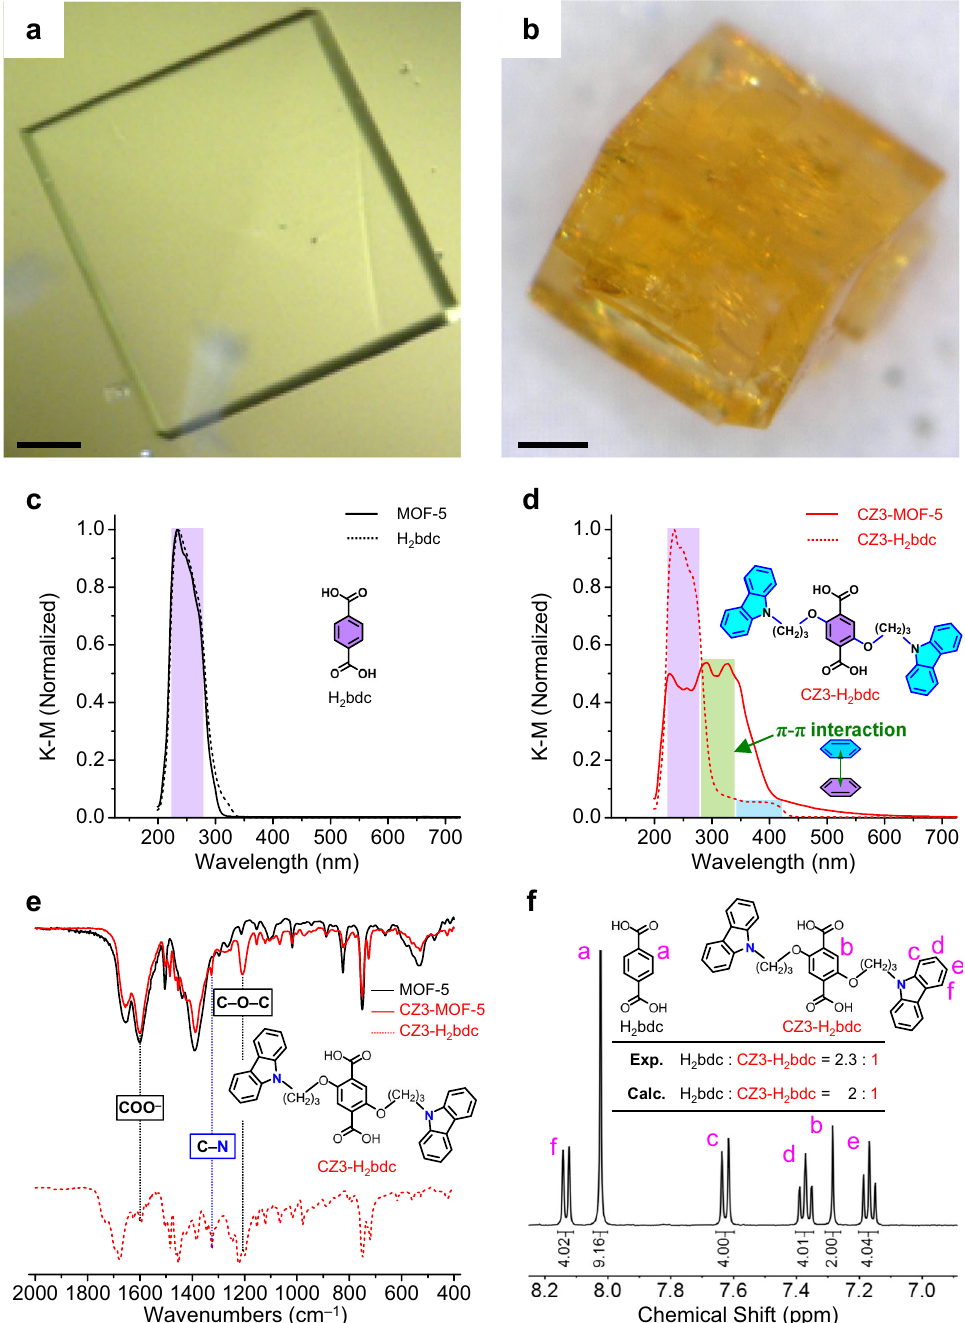
Fig. 4 Experimental characterizations of samples. Optical microscope images of a MOF-5 and b CZ3-MOF-5. Diffuse re fl ectance UV – vis absorption spectra of c H 2 bdc, MOF-5, and d CZ3-H 2 bdc, CZ3-MOF-5. e FT-IR spectra of MOF-5, CZ3-H 2 bdc, and CZ3-MOF-5. f 1 H NMR spectrum of CZ3-MOF-5 dissolved in a mixture of DCl/D 2 O and DMSO- d 6 solution. Inset: A peak integration ratio of the 1 H NMR signals for the ligands. Scale bars, 0.1 mm ( a ) and 0.1 mm ( b